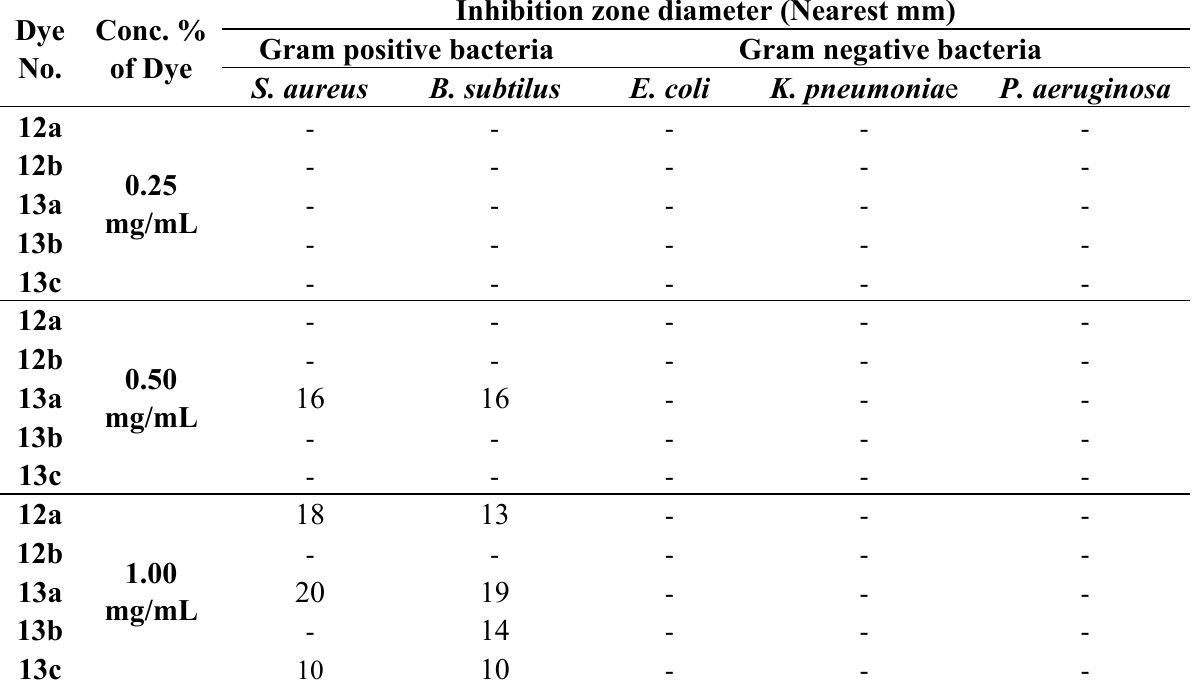
Table 3. Diameter of the zones of inhibition of the tested compounds that showed weak to strong antimicrobial against